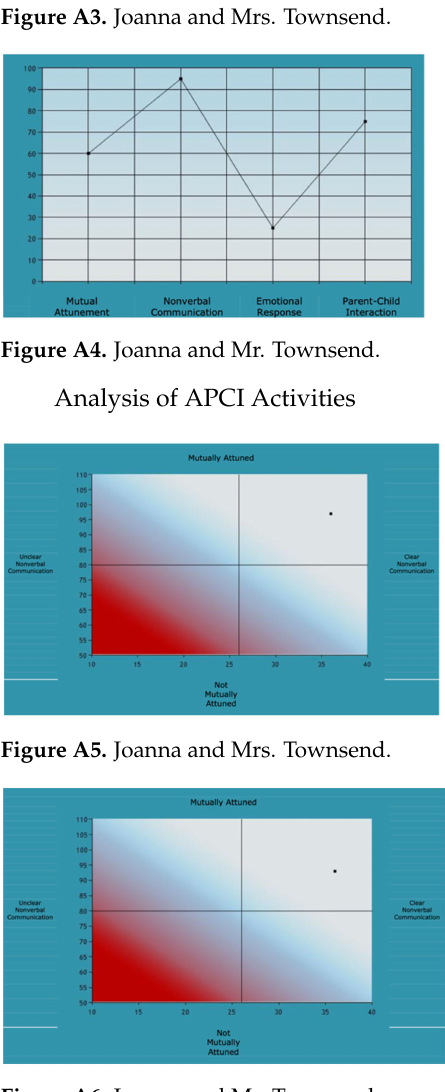
Figure A6. Joanna and Mr.